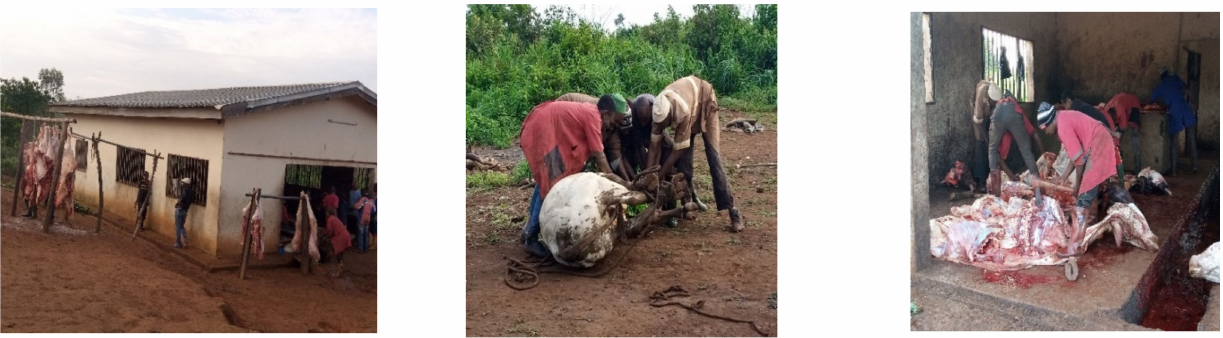
Figure 2. Slaughterhouse, slaughter and traditional treatment of carcasses in Ngaound é r é